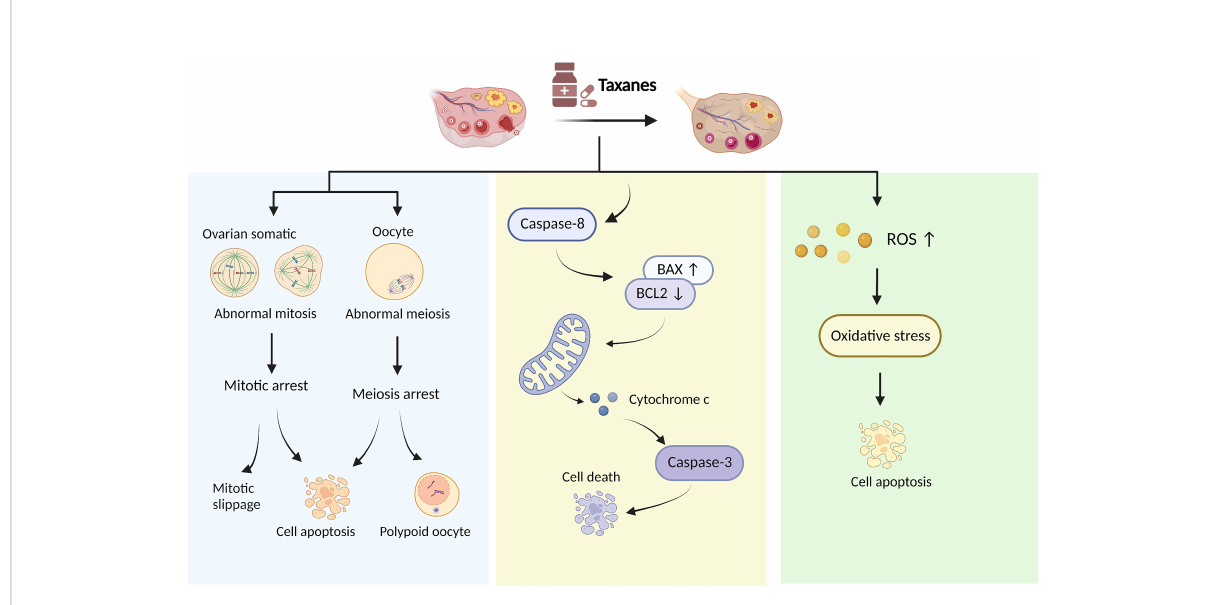
FIGURE 1 Proposed taxanes mechanisms of action in ovarian